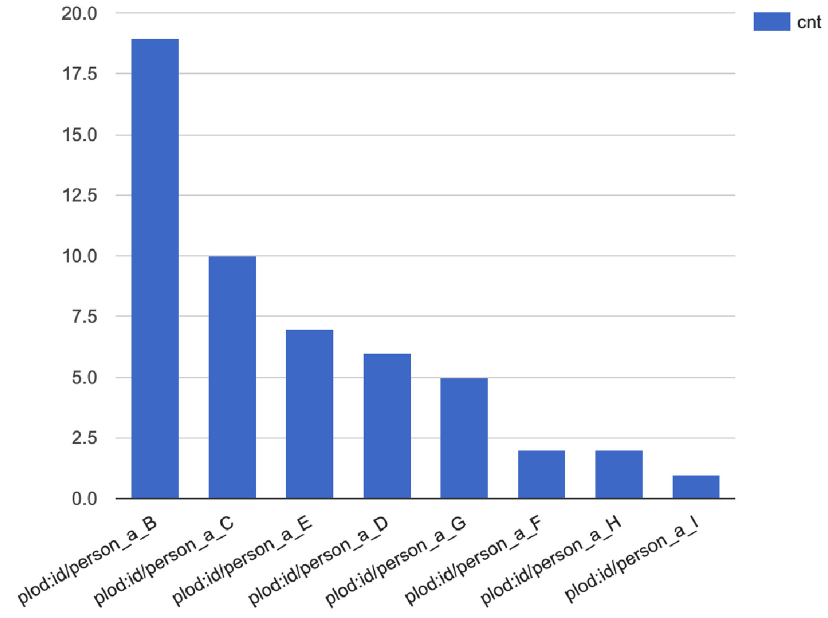
Fig 6. Visualization results of Fig 5. The horizontal axis represents the people who appear with Person A in the events of a closed situation, and the vertical axis represents the number of its appearance.